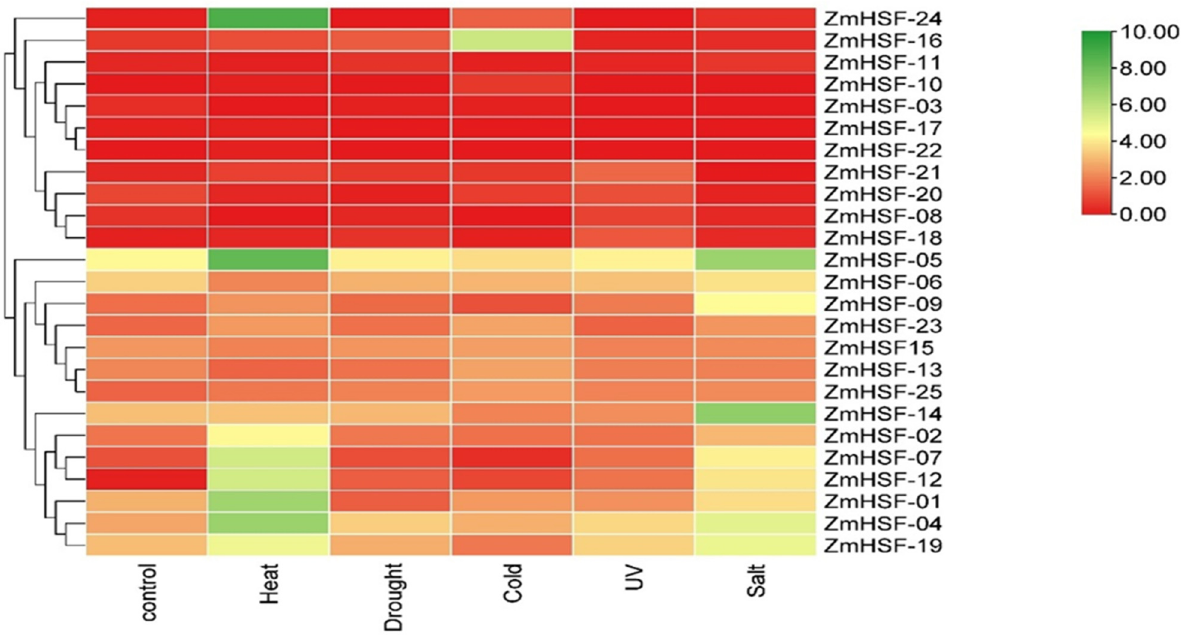
Figure 10. Expression profiles of maize HSFs under different abiotic stress conditions. Color bar at the top right represents the log-transformed FPKM values. Green represents higher, red lower, and yellow, medium transcript values.